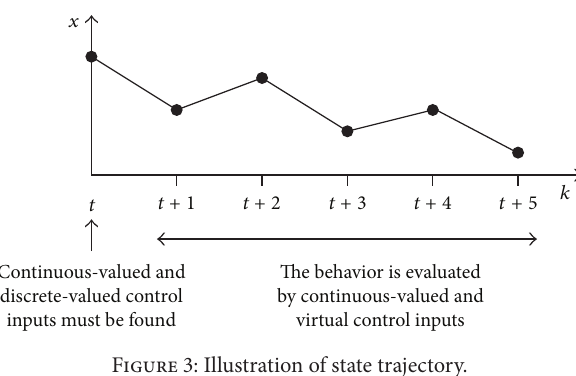
Figure 3: Illustration of state trajectory.